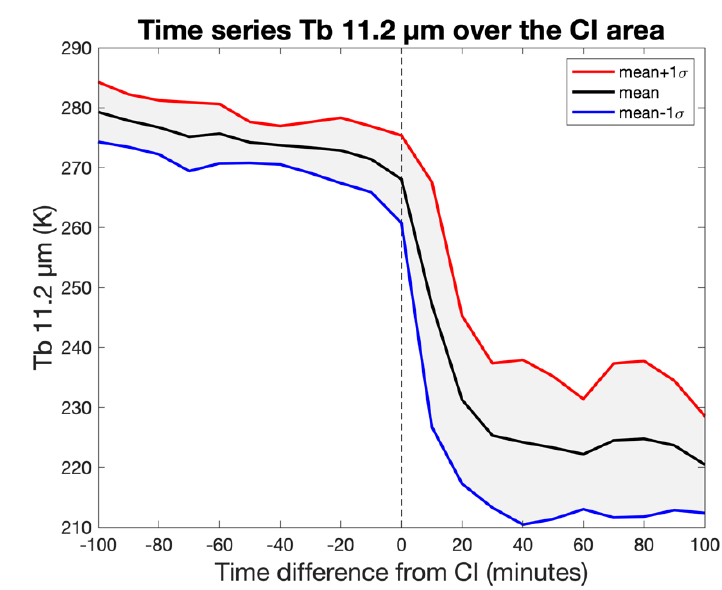
Figure 3. The variation of 𝑇 𝑏 (11.2) µm over the CI area from the samples obtained by the suggested automated sampling tool. Negative time differences in the x-axis refers to the time before the CI events, and the positive time difference represents after the CI events.